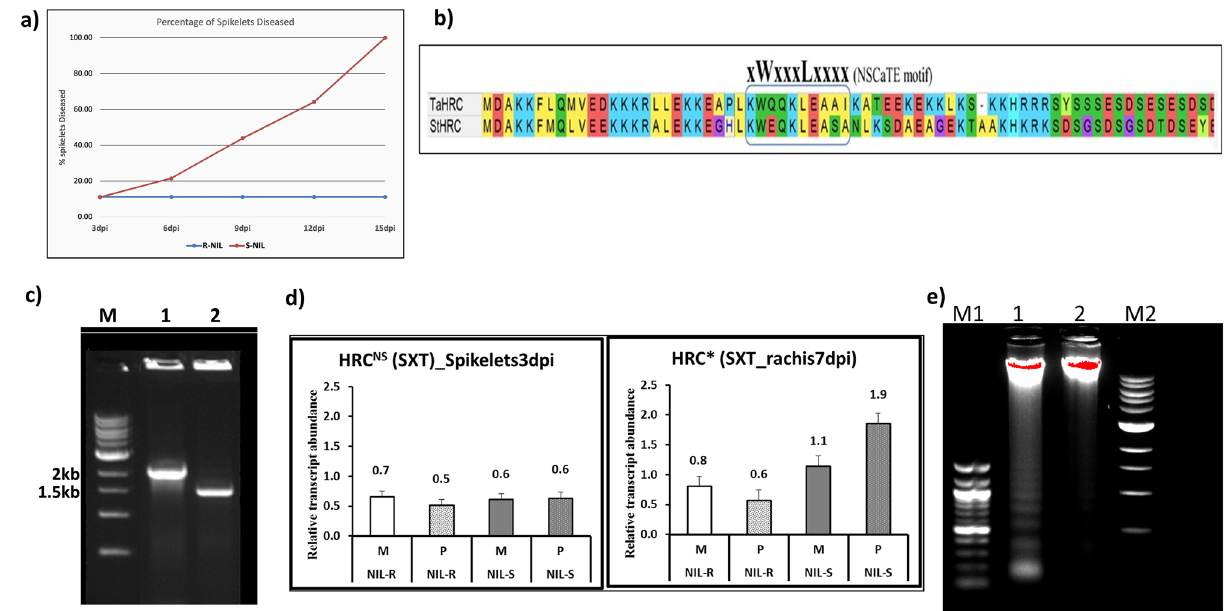
Figure 1. Wheat NILs possessing functional and mutated histidine rich Ca 2+ binding protein ( TaHRC or Tahrc ), inoculated with F. graminearum . ( a ) FHB disease progress, based on percent of spikelets diseased, in wheat resistant and susceptible NILs inoculated with F. graminearum. ( b ) TaHRC (Chinese spring wheat) and StHRC (Russet Burbank potato) genome sequences with CaM binding site, NSCaTE. ( c ) The DNA size of the wheat genes TaHRC in S-NIL (1) and Tahrc in R-NIL (2), M = 1 kb DNA marker ladder; ( d ) TaHRC and Tahrc gene expression in wheat FHB susceptible S-NIL and resistant R-NIL inoculated with F. graminearum, where M is mock, P is pathogen inoculated; ( e ) DNA laddering in wheat NILs inoculated with F. graminearum , the original gel pictures, M = DNA ladder, 100 base pairs (M1) and 1 kb (M2), 1 = HRC in S-NIL and 2 = hrc in R-NIL of